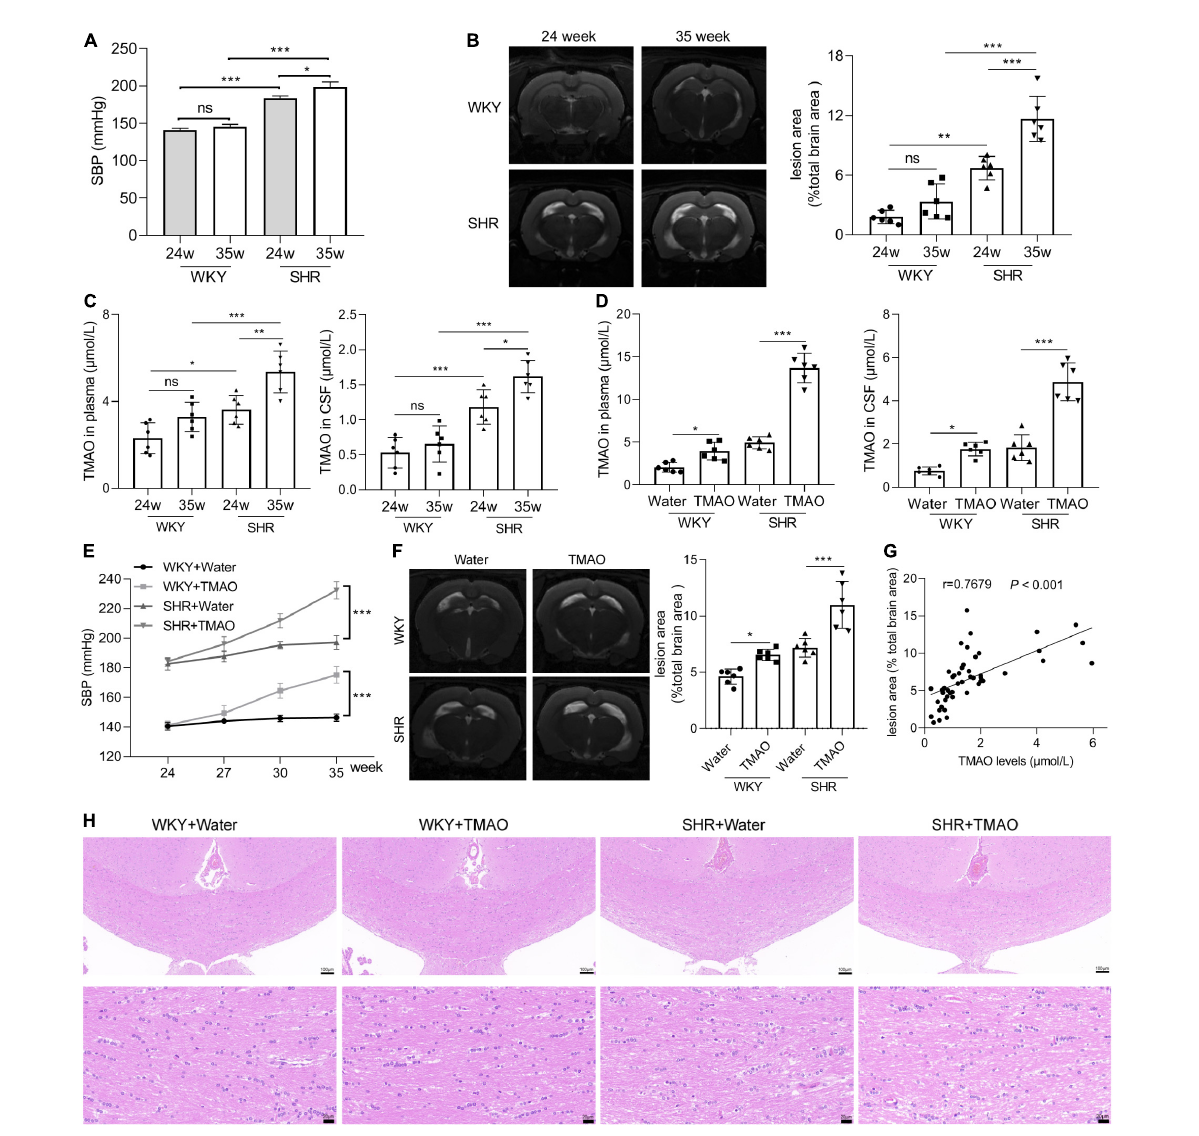
FIGURE1 Increased TMAO promoted white matter lesions. (A) Systolic blood pressure (SBP) at 24 and 35 week of WKY and SHR ( n = 6/group). (B) Images and quantation of T2-weighted MRI in 24- and 35-week SHR and age-matched normotension WKY rats. (C) TMAO level in plasma and CSF detected by LC-MS/MS ( n = 6/group). 24-week-SHR and age-matched normotensive WKY rats were treated with TMAO for 11 weeks. (D) TMAO level in plasma and CSF detected by LC-MS/MS ( n = 6/group). (E) SBP at different ages of WKY and SHR treated with TMAO ( n = 6/group). (F) Images and quantation of T2-weighted MRI in SHR and WKY rats. (G) The relationship between TMAO levels and white matter lesion in brain was analyzed using Spearman correlation analysis. (H) Changes in white matter injury detected by H&E staining. Scale bar: upper, 100 µ m; lower, 20 µ m. The data were expressed as mean ± SD of three independent experiments. ns, no significance. * P < 0.05, ** P < 0.01, *** P <